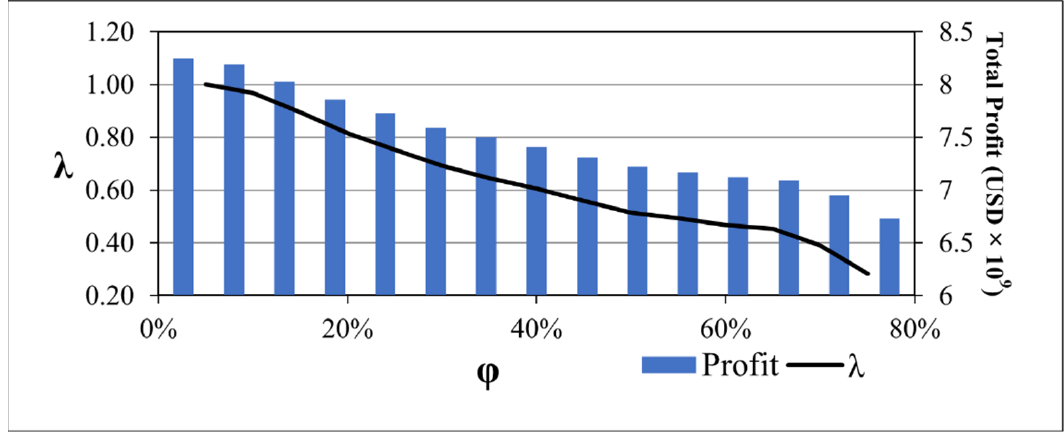
Figure 6. The relationship between ϕ , λ , and total profit. Figure 7 and Table 6 present the fluctuation in the electric energy generation amount of the GenCo based on different ϕ values from the maximum electric energy output level (cid:18) (cid:19) π + that hydroelectric generation units can reach. As ϕ increases, the maximum O H i , y electrical energy output that hydroelectric generation units can produce diminishes based on the technological constraint (3). Hence, the total electricity generation amount for hydroelectric generation units of the GenCo reduces.